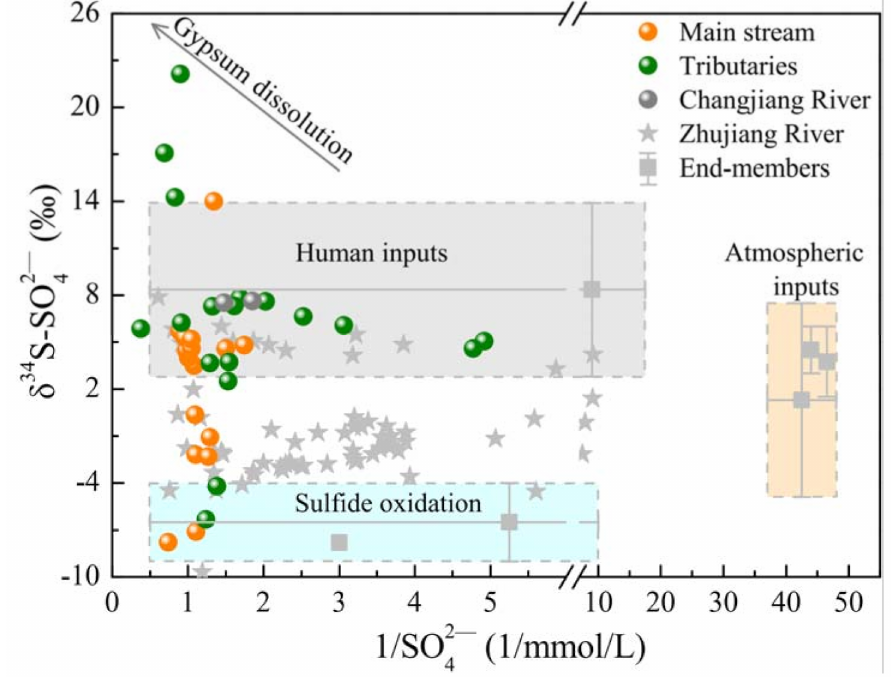
Figure 5. The relationship between δ 34 S–SO 4 2 − values and SO 4 2 − concentrations revealing the mixing processes of riverine sulfate from different sources. The data of Zhujiang River is from